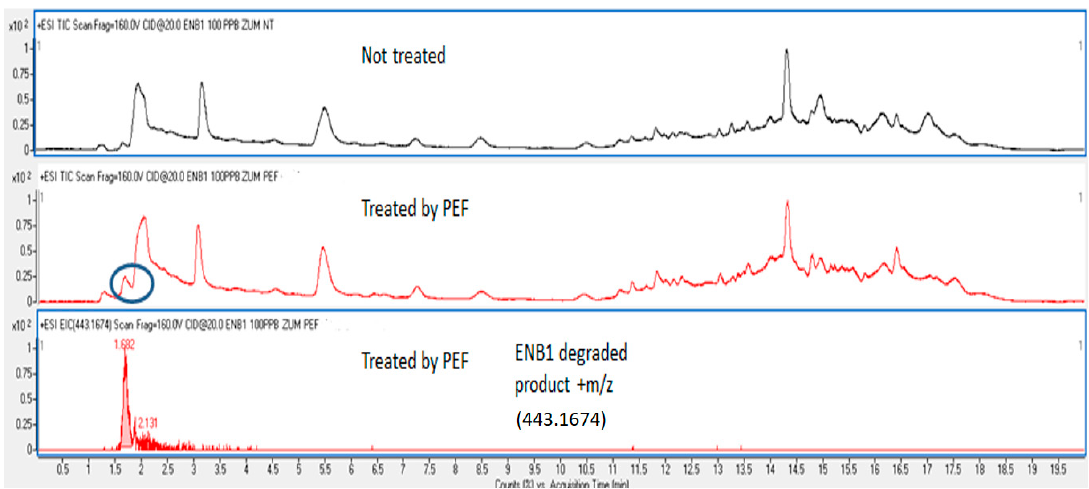
Figure 4. LC-ESI-qTOF-MS chromatogram of degraded product ENB1 m / z 443.1674 obtained in matrix samples after PEF treatment.